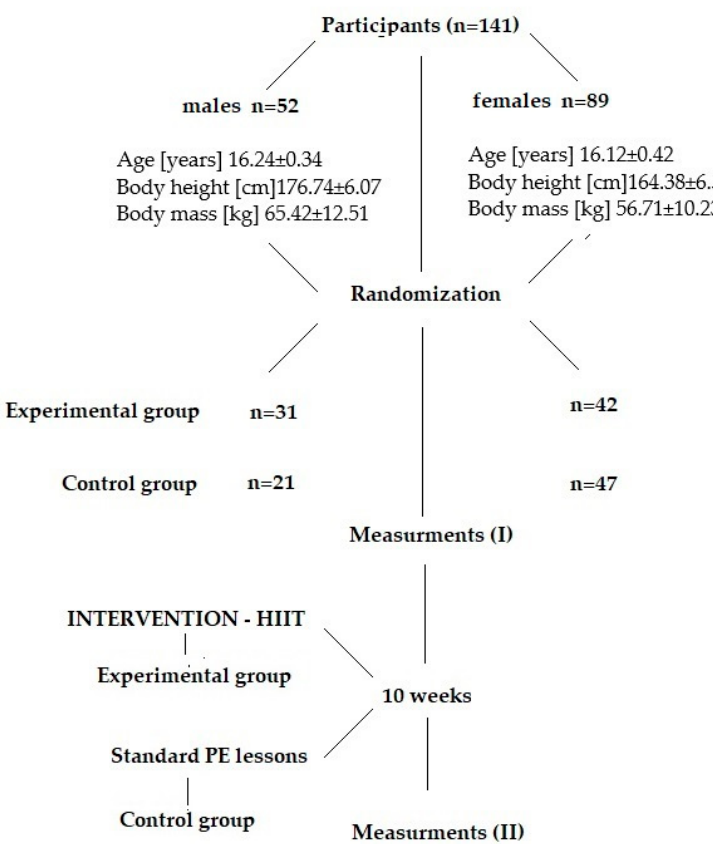
Figure 1. Descriptive characteristics of the participants and study design.